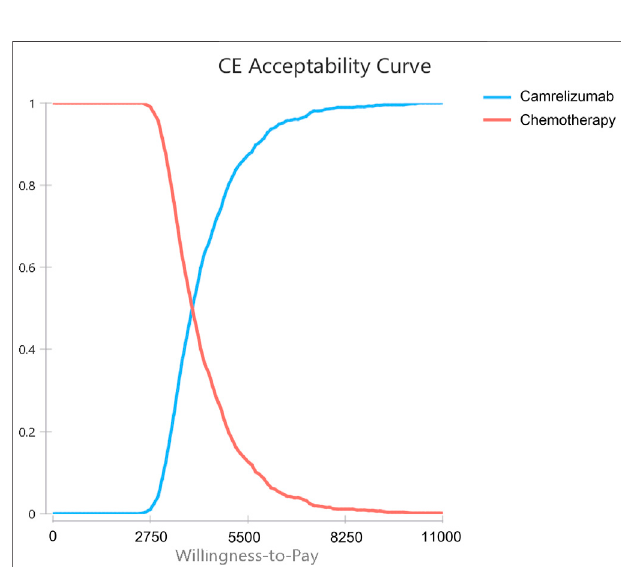
FIGURE 3 | Cost-effectiveness Acceptability Curves. Results of probabilistic sensitivity analyses for camrelizumab versus chemotherapy after 10,000 Monte Carlo simulations, which indicates the probability of cost- effectiveness at different willingness-to-pay thresholds based on the uncertainty of the